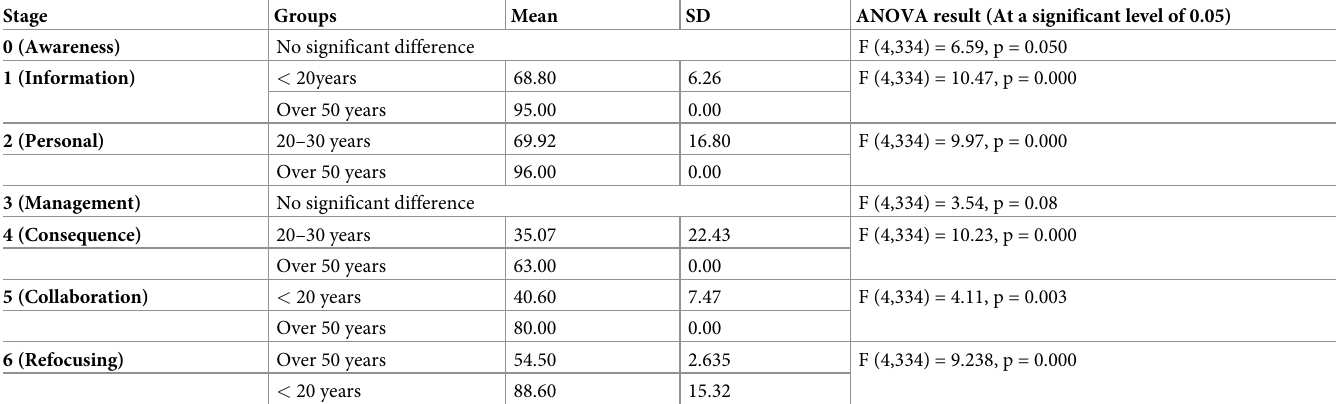
Table 6. Results of One-way ANOVA for the effect of age on the intensity of teacher’s concern across all stages.